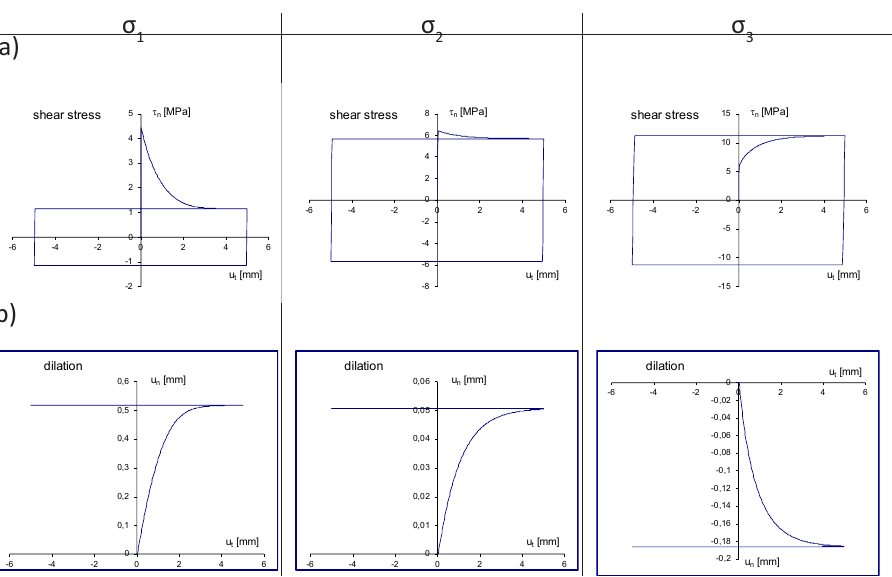
: a) variations of shear stress, t